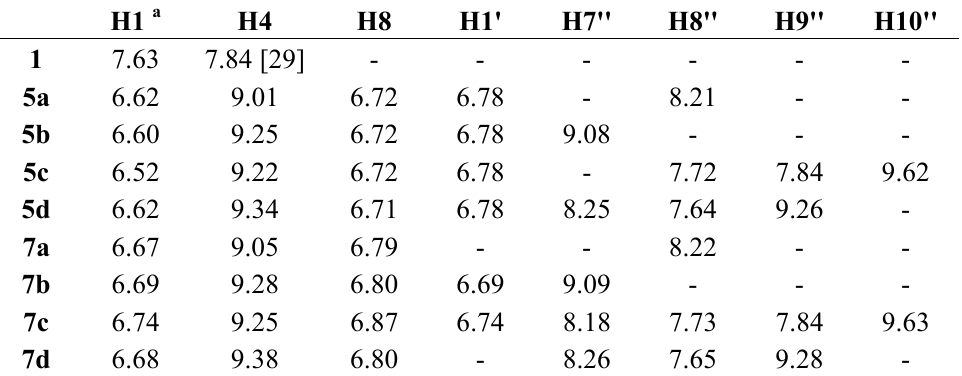
Table 1. Selected proton resonances for compounds 5 and 7